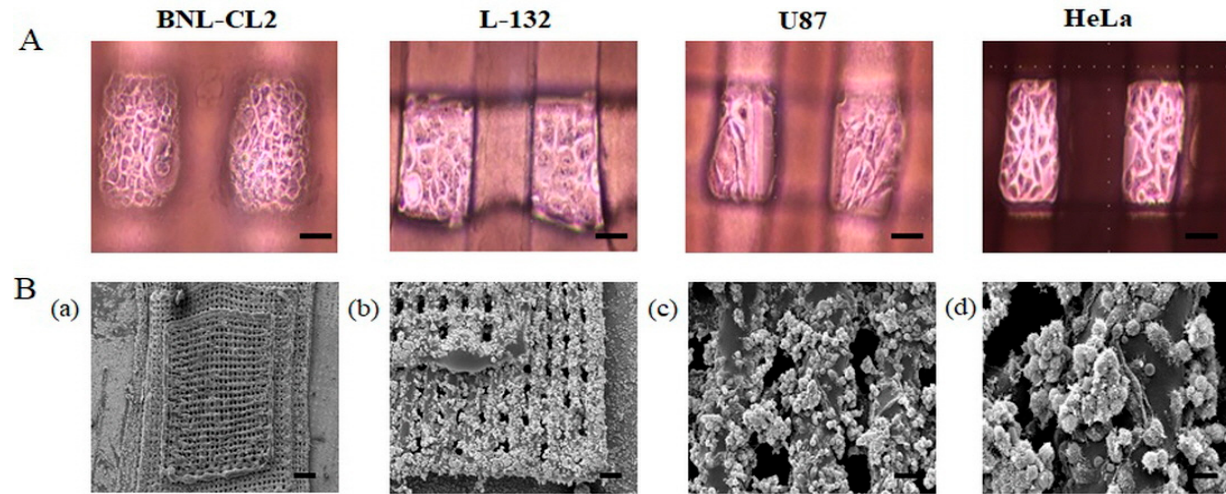
Figure 3. ( A ) Optical images of the four cell types (BNL-CL2, L-132, U87, and HeLa) cultured on a polydimethylsiloxane (PDMS) multi-channel cell chip with a polycaprolactone (PCL) three-dimensional (3D) scaffold. ( B ) SEM image of HeLa cells cultured on the PDMS multi-channel cell chip with a PCL 3D scaffold ( a ); scale bar: 1 mm). Partially magnified SEM image of HeLa cells cultured on the first and second floors of the 3D structure ( b ); scale bar: 200 µm). Partially magnified SEM image of HeLa cells cultured on the first floor of the 3D structure ( c ); scale bar: 50 µm). Partially magnified SEM image of the third floor of the 3D structure ( d ); scale bar: 10 µm).